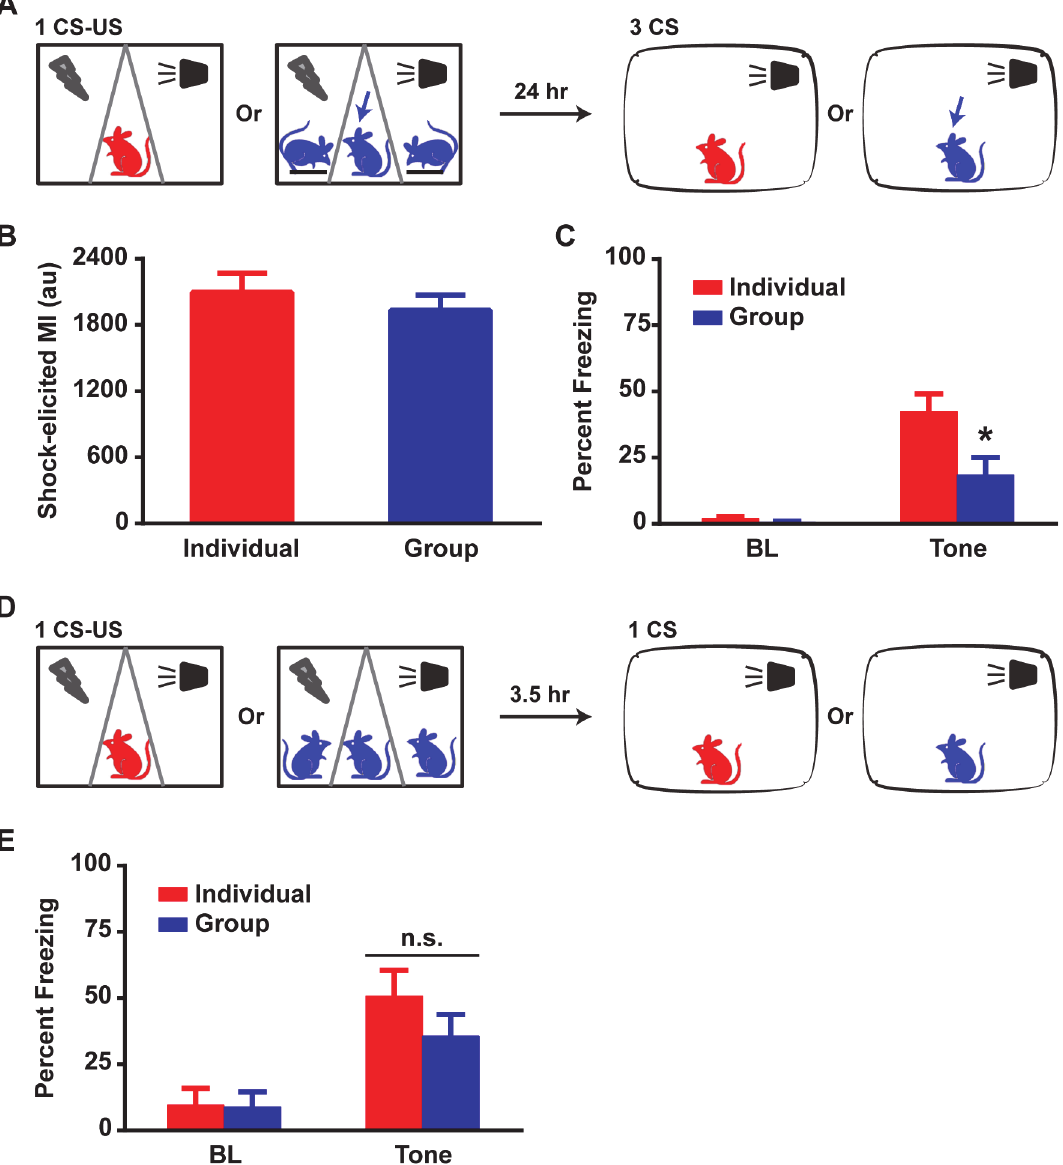
Fig 2. Group-induced fear reduction occurs despite similar fear acquisition in Individuals and Groups. (A) Schematic: in each Group conditioning context, 2 rats are anesthetized and placed on platforms while the third rat is placed awake in the center compartment. Twenty-four hours later, Individual and non-anesthetized Group rats are exposed to three CS presentations in a different context for LTM testing. (B) Shock-induced MI revealed no significant differences between Individuals and Groups (unpaired t-test, p > 0.1). (C) Group rats freeze significantly less than Individuals during CS presentation. Two- way RM ANOVA revealed an effect of condition, F (1, 31) = 7.00, p < 0.05, and an interaction, F (1, 31) = 5.90, p < 0.05. Post-hoc tests revealed no differences for BL, p > 0.1, and a significant reduction in Group CS freezing, p < 0.01. (D) Schematic: Individuals and Groups are fear-conditioned with 1 CS-US pair and are exposed 3.5 hours later to a single CS presentation for STM testing. (E) Individuals and Groups displayed similar levels of freezing during CS presentation. Two-way RM ANOVA did not reveal any significant effect of condition, F (1, 28) = 0.85, p > 0.1 or an interaction, F (1, 28) = 1.25, p > 0.1. MI: motion index; au: arbitrary unit. Data presented as mean + sem.